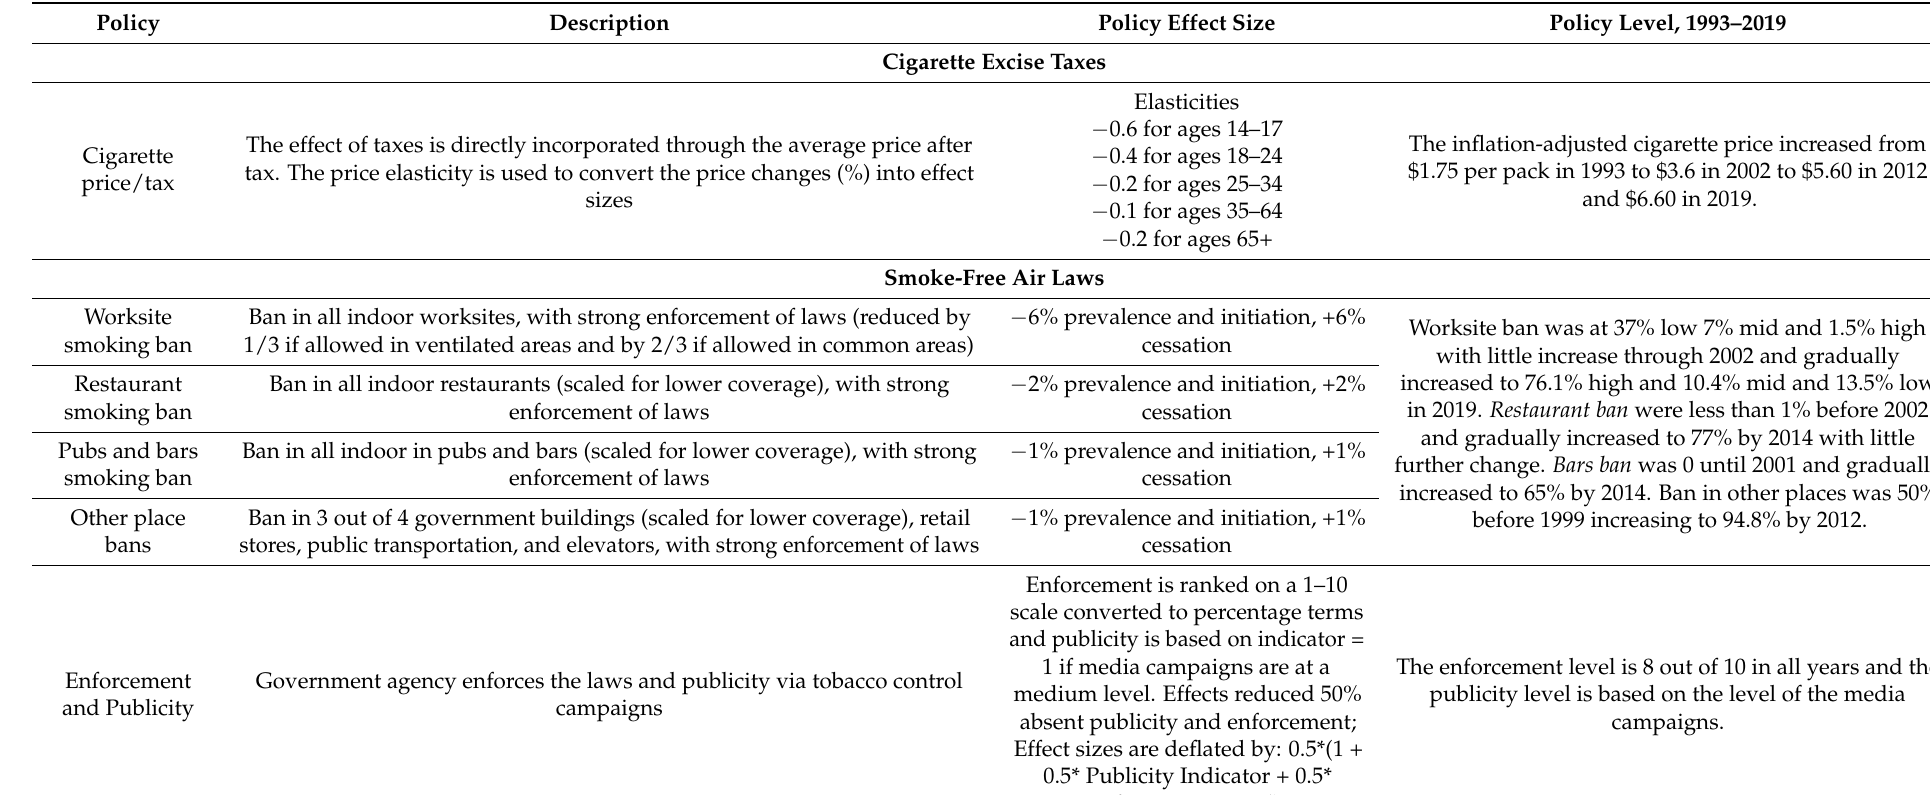
Table 1. Tobacco control policies, specifications and effect sizes applied in US SimSmoke